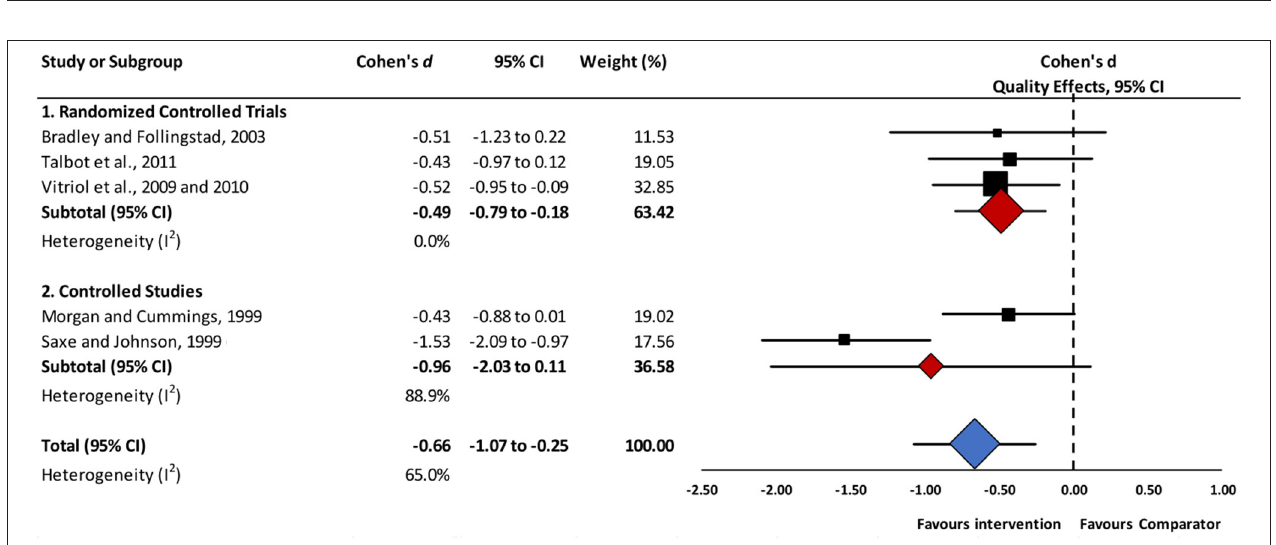
FIGURE 3 | Mid-term effects of interventions vs. comparators in reductions of depressive symptoms. Abbreviations. 95% CI, 95% confidence interval. Mid-term effects: assessment up to 24-weeks follow-up.